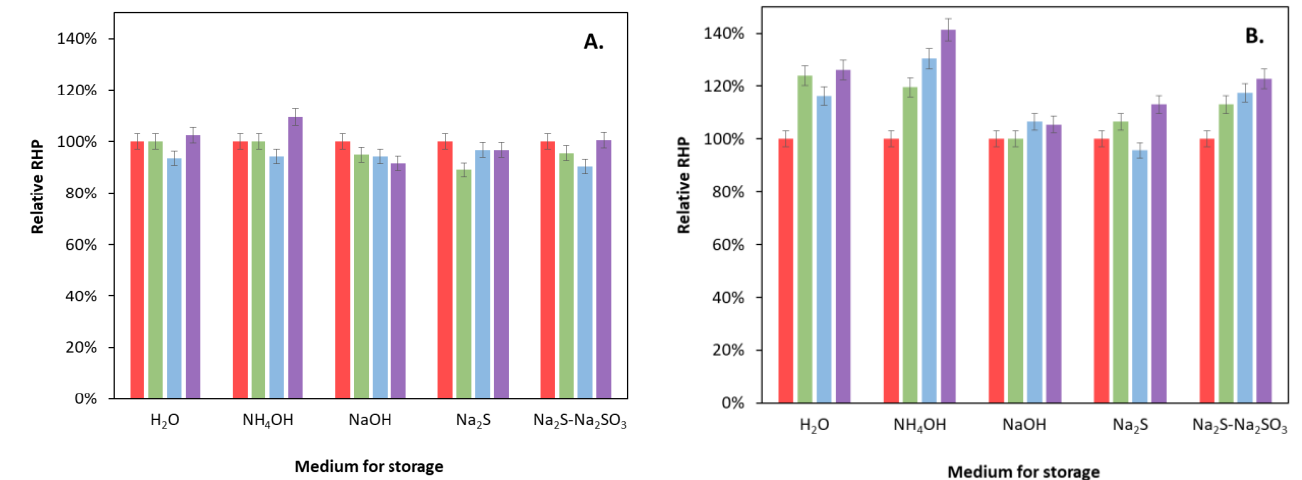
Figure 9. Changes in the RHP for hydrothermally treated catalysts (unmodified ( A ); modified with 0.5% Ni(II) in the bulk ( B )) during storage in various media. Red, green, blue, and violet colors indicate the results after 0, 4, 7, and 12 months of storage, respectively. (The red columns, indicating the starting states, represent the references, i.e., 100%).